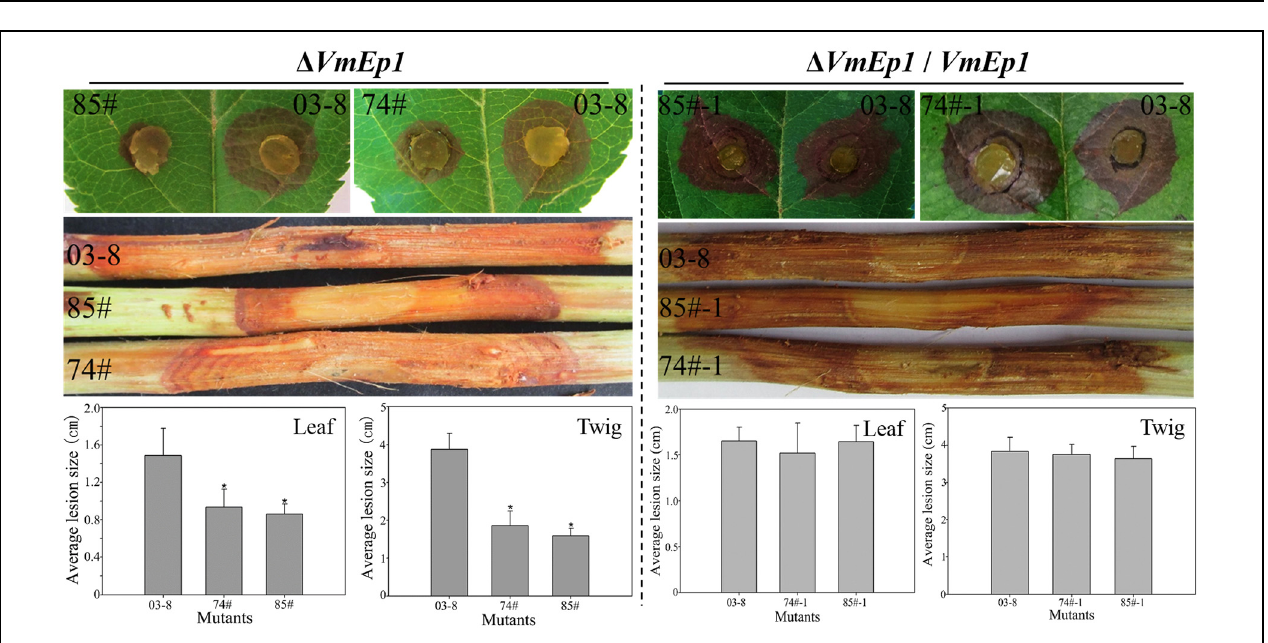
FIGURE 6 | Pathogenicity of mutants. Wild-type (03–8), VmEp1 deletion mutants (74#) and (85#), and complementation mutants (74#-1) and (85#-1) were inoculated on leaves and twigs of Malus domestica borkh. cv. ‘Fuji’ for